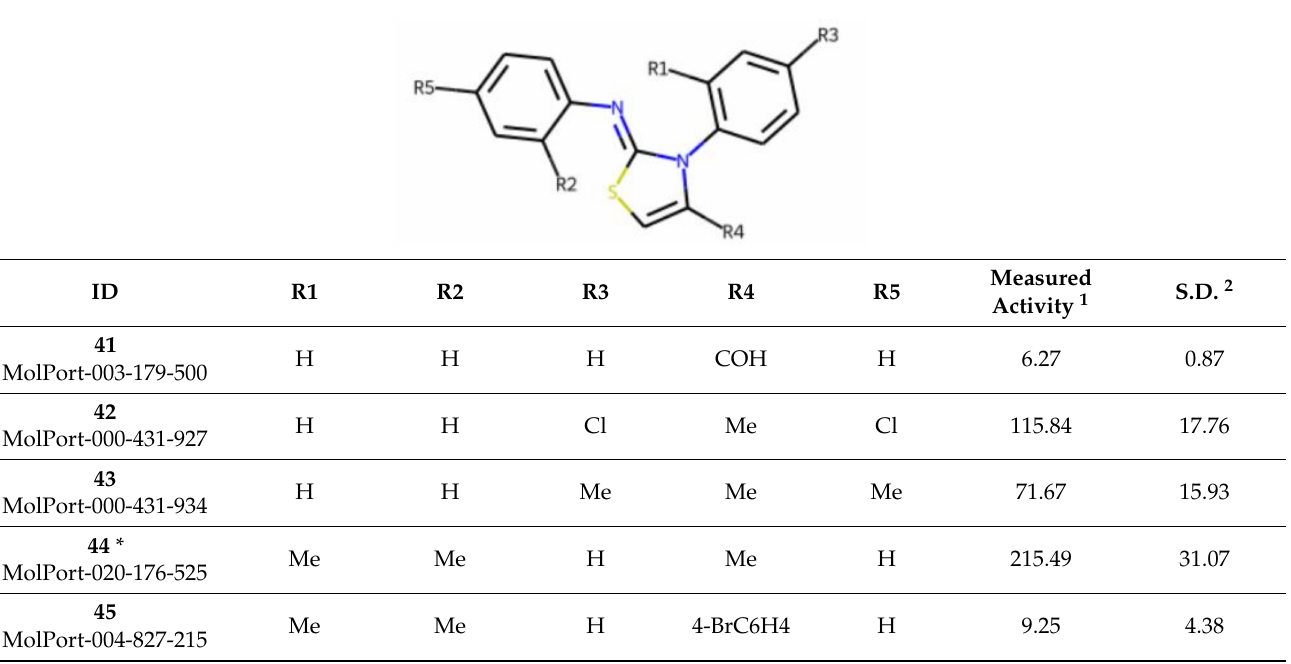
Table 6. Compounds tested in follow-up experiments related to 22